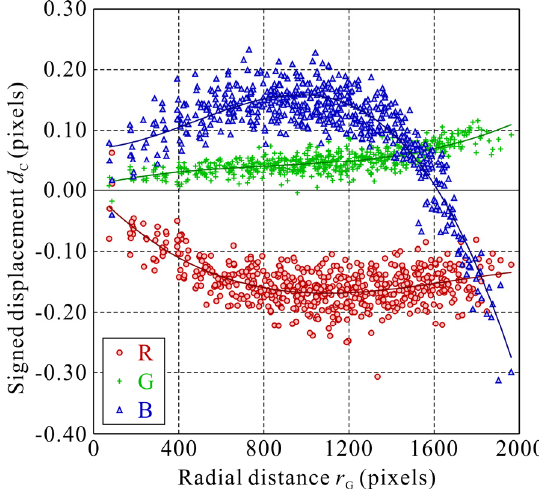
Figure 12. Signed displacements caused by lossy JPEG compression with 2x2 1x1 1x1 sampling in the image shown in Figure 2 (Mode: